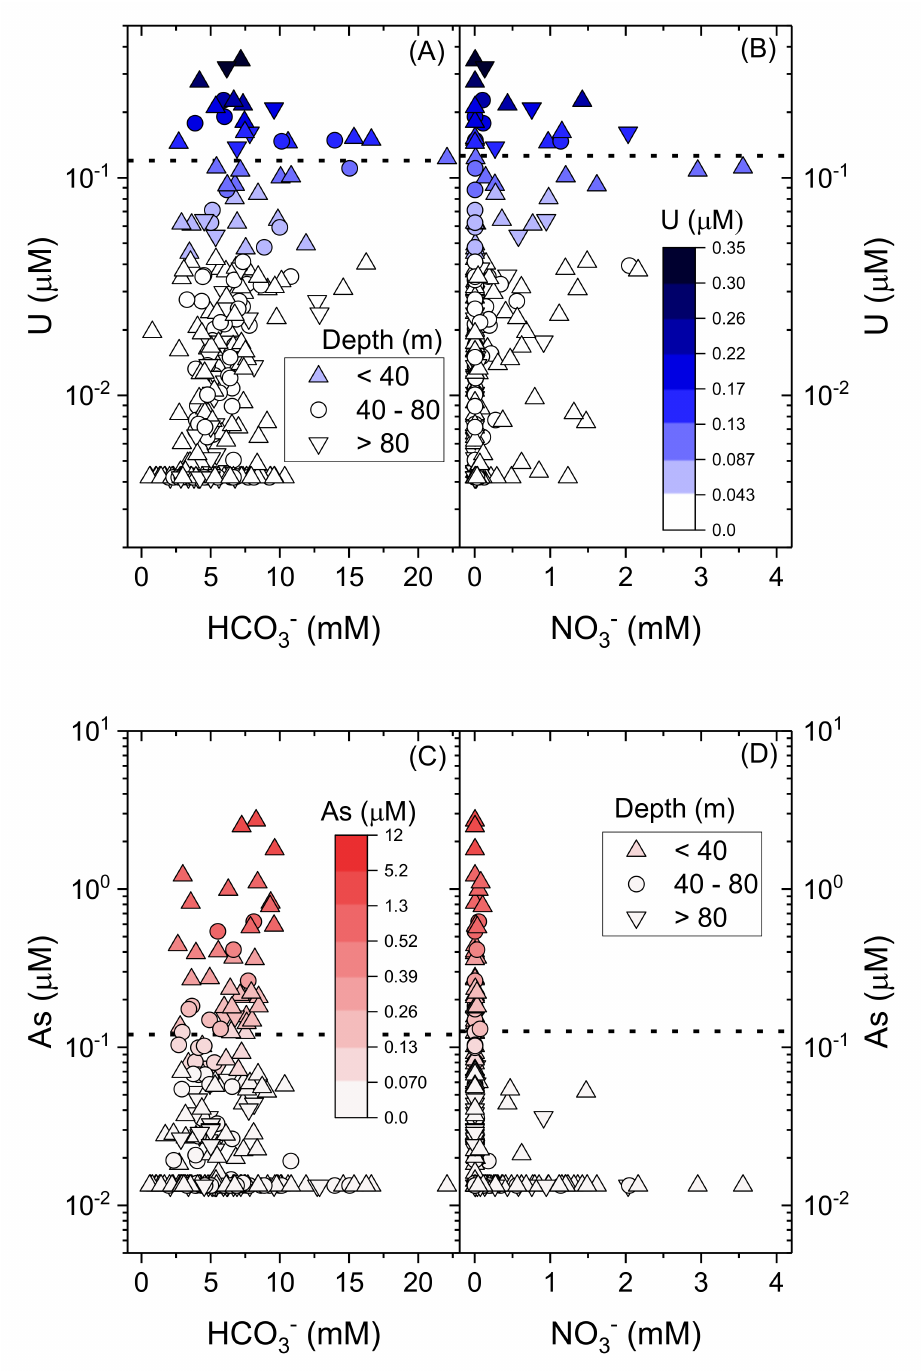
Figure 11. U (log-scale) versus ( A ) estimated HCO 3 − and ( B ) NO 3 − with the WHO provisional guideline [4] of 0.13 µ M (30 µ g.L − 1 ) for U in dotted line. As (log-scale) versus ( C ) estimated HCO 3 − and ( D ) NO 3 − with the WHO provisional guideline [4] of 0.13 µ M (10 µ g.L − 1 ) for As in dotted line. Symbol shape indicates reported depth; colour scale indicates U (blue) and As (red) concentrations. Samples with measured concentrations below detection for a particular analyte are shown as maximum concentration at method detection